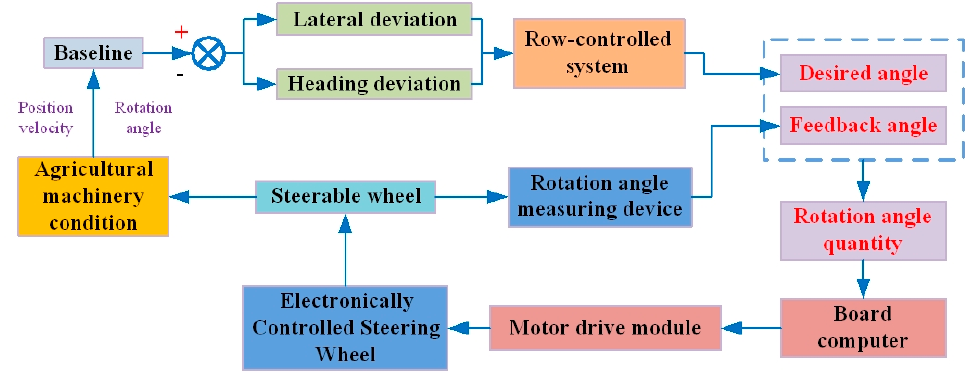
Figure 4. Principle of row-controlled system.